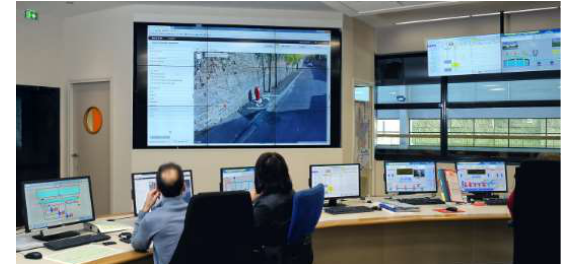
Figure 1 The HUBLO control room, drinking water monitoring